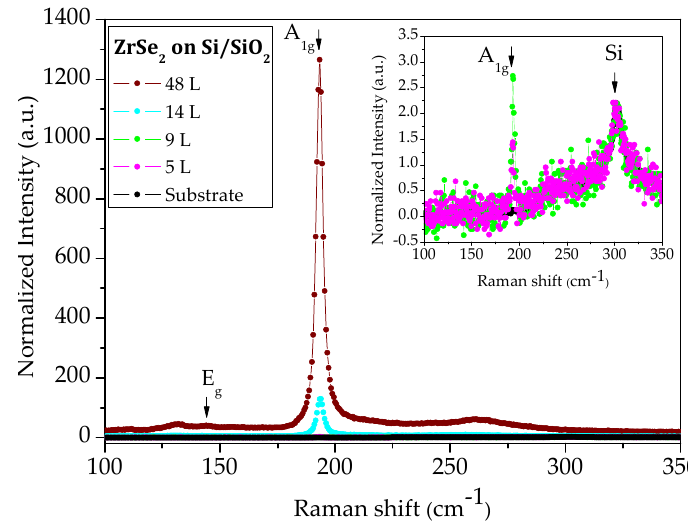
Figure 4. Thickness dependence of the Raman spectra for ZrSe 2 ( λ = 638 nm) on a silicon substrate with 285 nm of SiO 2 . Inset: zoom of Raman spectra in the A 1g characteristic peak for the thinnest layers. The intensity has been normalized to the height of the silicon phonon peak.